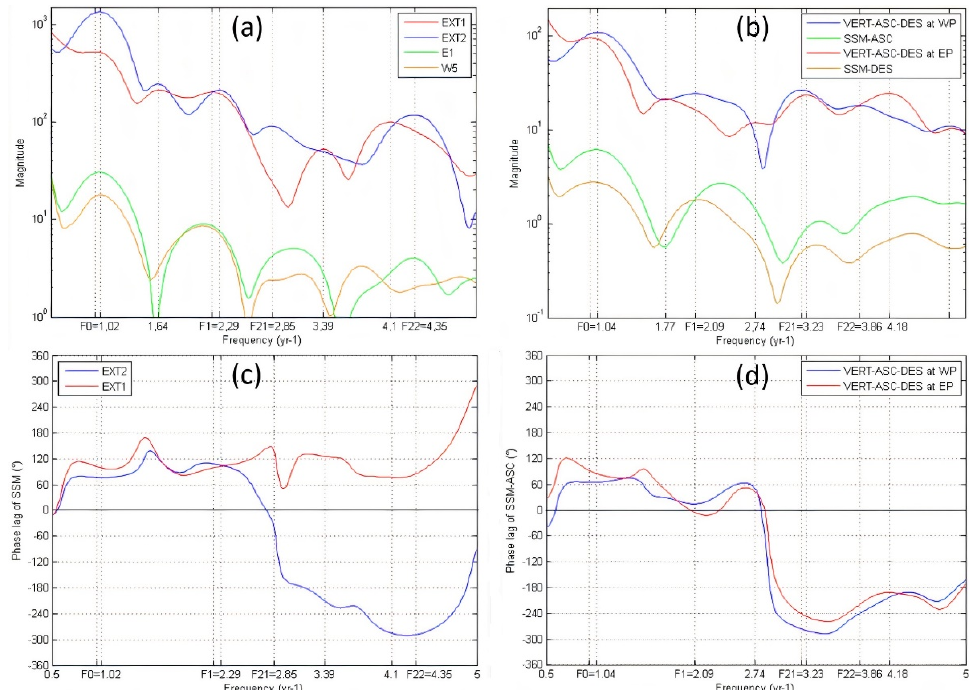
Figure 6. In the top, the magnitude of the Fast Fourier Transform (FFT) of different time series between frequencies 0.5 and 5 year − 1 are shown: ( a ) vertical displacement of both extensometers (EXT1 and EXT2) and the Soil Moisture at E1 and W5 (about 1.2 m depth), ( b ) VERT-ASC-DES for vertical displacement using ascending and descending S-1A/1B tracks at West Point (WP) and East Point (EP), and SSM-ASC and SSM-DES for the Surface Soil Moisture using the ascending and descending SMOS track, respectively. In the bottom, the phase angle difference in degrees between the FFT of the SSM-ASC using SMOS ascending track and the FFT of the displacement of four time series are shown: ( c ) EXT1 and EXT2 and ( d ) VERT-ASC-DES at WP and EP.